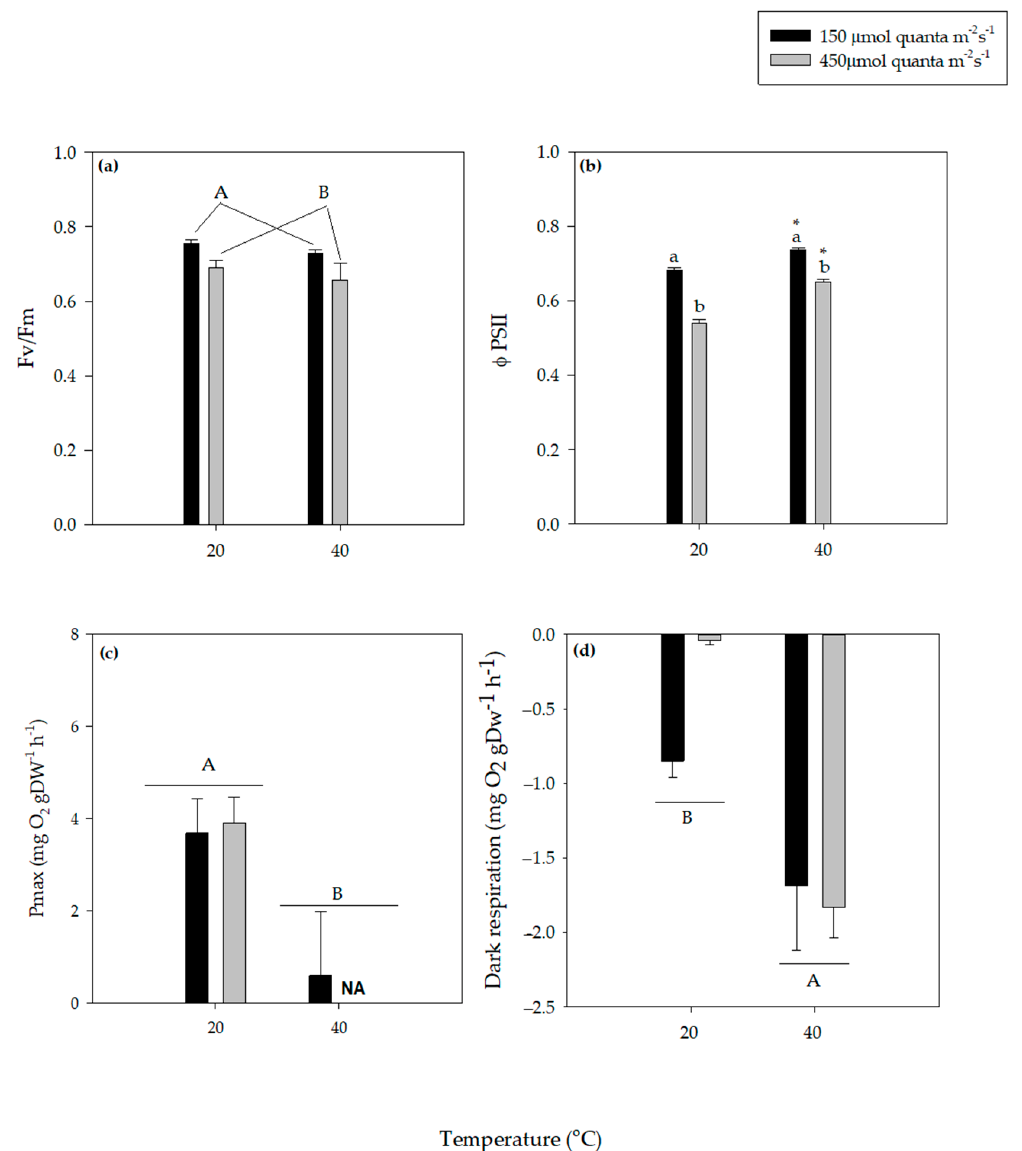
Figure 1. Effects of temperature and light on Cymodocea nodosa: ( a ) PSII maximal photochemical efficiency (Fv/Fm); ( b ) effective quantum yield of photochemical energy conversion in PSII ( ɸ PSII); ( c ) Maximum photosynthesis (Pmax), NA—the dispersion of the points under this condition did not allow the adjustment to calculate the parameters; ( d ) and dark respiration. Values represent mean ±SE ( n = 3). Different letters indicate significant differences among light levels under the same temperature ( p < 0.05, SNK test); * indicate significant differences among temperatures under the same light level ( p < 0.05, SNK test); capital letters indicate differences among temperature or light independently of the other factor (no interaction among factors; p < 0.05, SNK test).